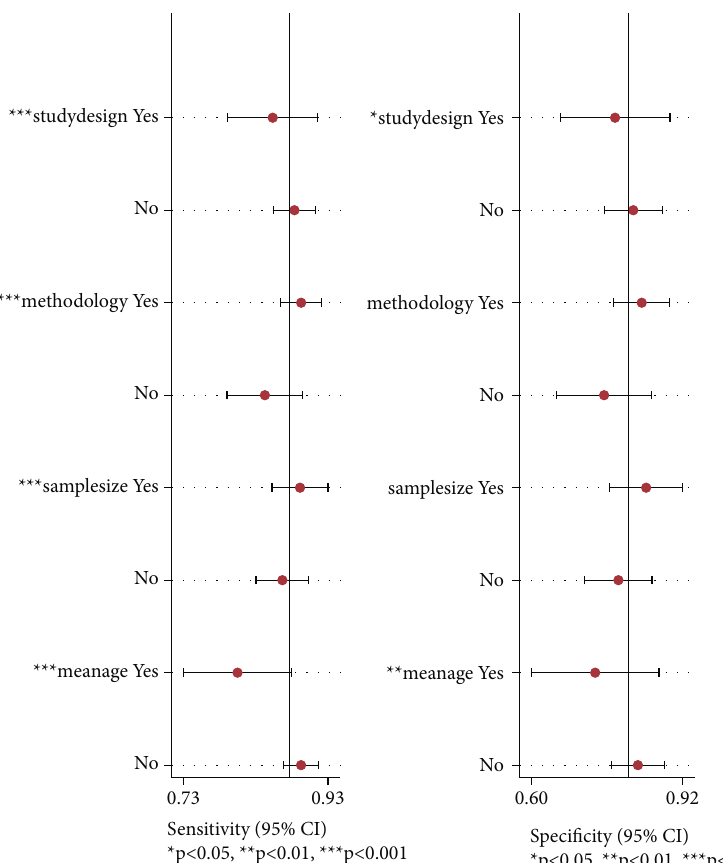
Figure 6: Meta-regression analysis of different study designs, methodologies, sample sizes and mean ages.